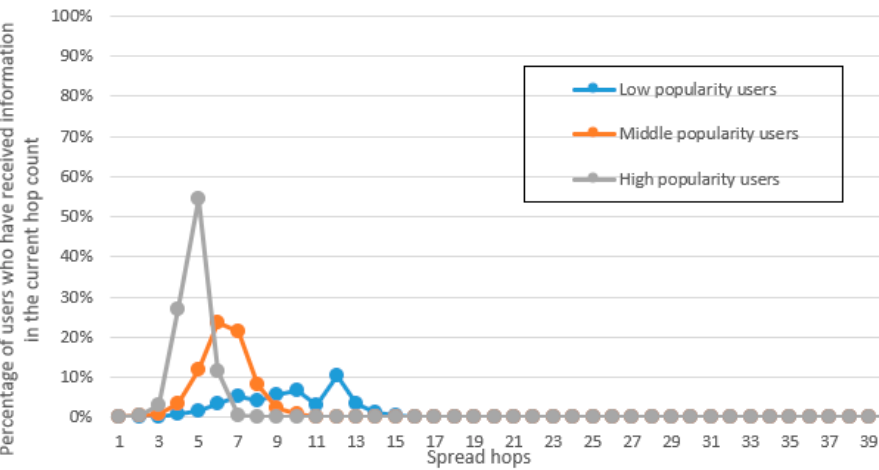
Figure 5. Privacy dissemination in each round vs. popularity.